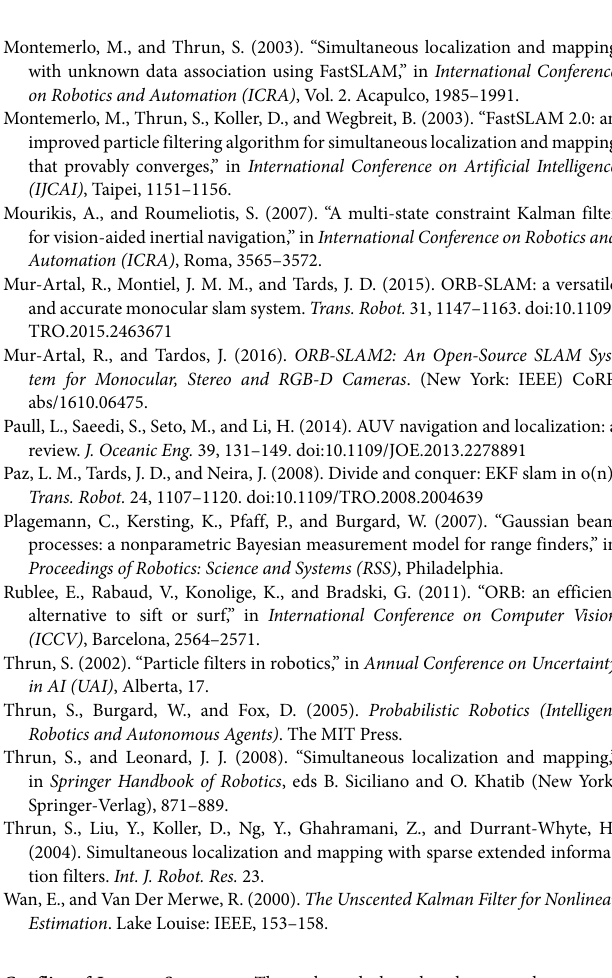
VIDEO S1 | Top left : initial marginals, the blue and red probability density functions (solid red and blue) represent the belief the agent has of his position and that of the